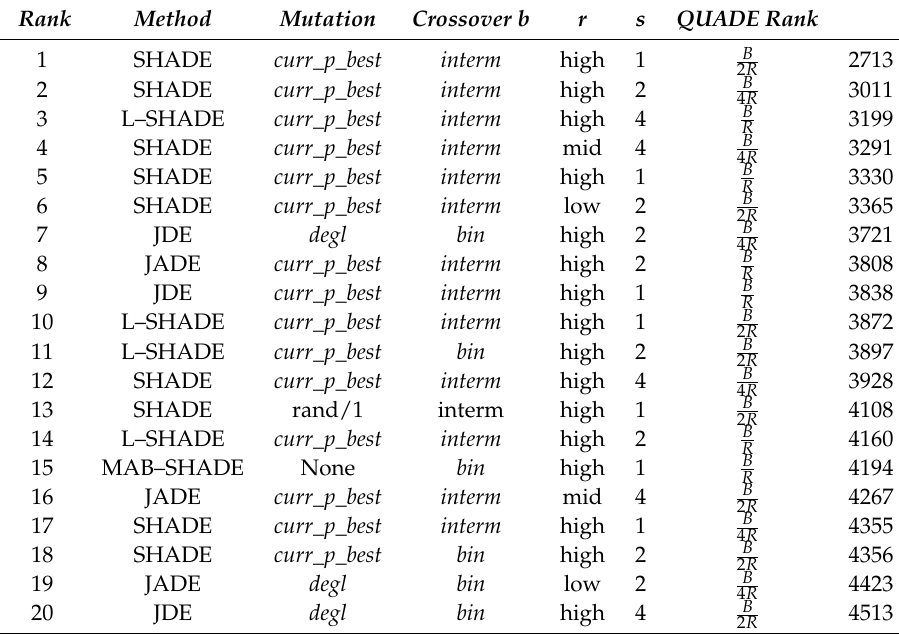
Table 3. Top 20 Quade ranking for parameter